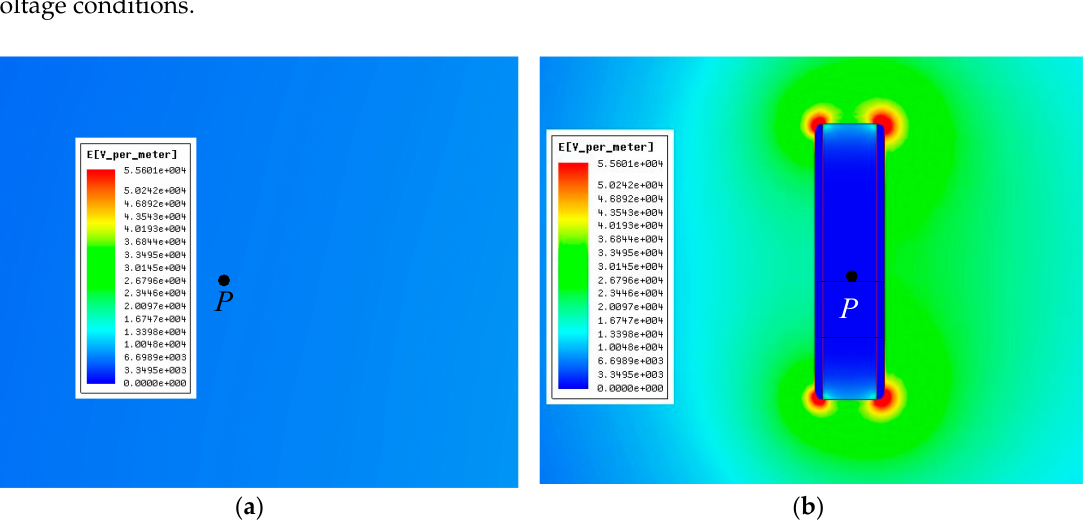
Figure 5. Electric field spatial distribution surrounding observation point P (no influence of a human body). ( a ) Before placing the sensor; ( b ) after placing the sensor.